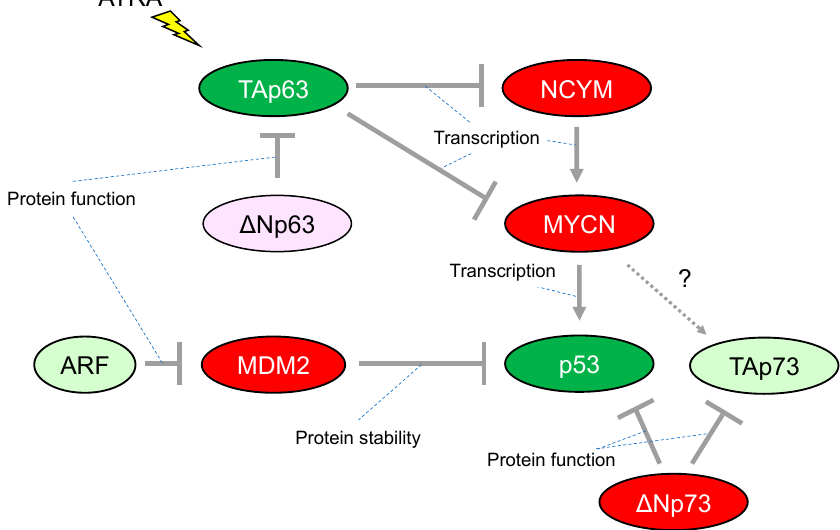
Figure 2. Characteristic alteration of TP53-family-related pathways in neuroblastoma. The red-colored or green-colored molecules indicate oncogenes or tumor-suppressors in neuroblastomas, respectively. The light-pink-colored or light-green-colored molecules could positively or negatively affect neuroblastoma proliferation, respectively. Interaction between TAp73 and MYCN is unknown. ATRA, All-trans-retinoic acid.